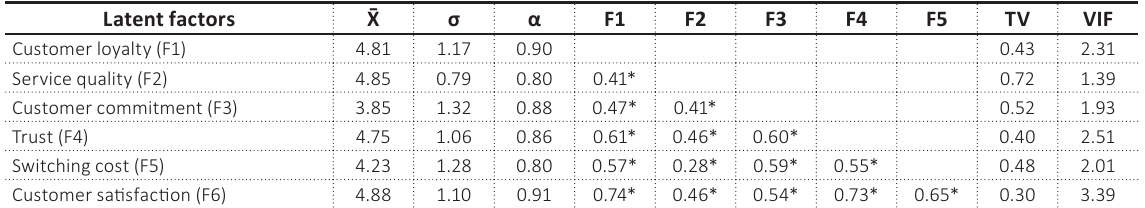
Table 2. Descriptive, reliability, correlation and collinearity statistics